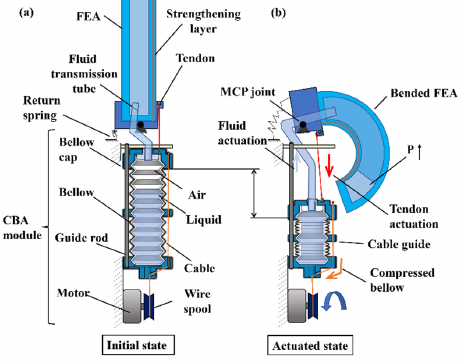
Figure 1. Concept of the DASA. ( a ) The DASA at initial state. ( b ) The DASA at an actuated state by compressing bellow. compressing